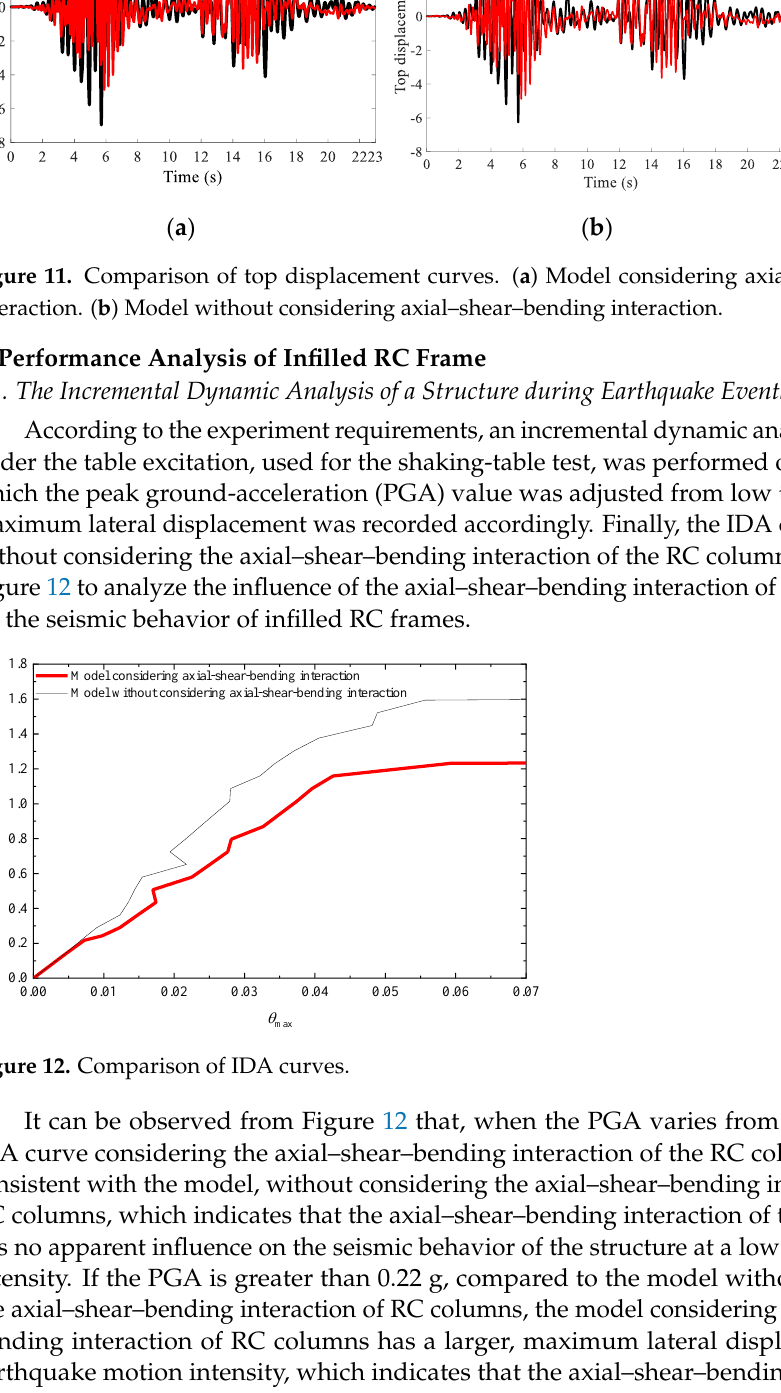
Figure 13. Comparison of pushover curves. It can be observed from Figure 13 that, when the top displacement is less than 50 mm, the pushover curves obtained from the two models are almost equal. When the top displacement is greater than 50 mm, yield occurs when considering the axi- al – shear – bending interaction of RC columns; then, the pushover curve shows a degra- dation stage. Similarly, after the top displacement exceeds 53 mm, yield occurs without considering the axial – shear – bending interaction of RC columns and the pushover curve also shows a continued degradation stage. As the top displacement increases, the curve considering the axial – shear – bending interaction of RC columns degrades more rapidly than the curve without considering the axial – shear – bending interaction of the RC col- umns. When the roof drift ratio reaches 3.5% (top displacement equal to 100 mm) and 5.0% (top displacement equal to 150 mm), the difference in the load capacity between the two models is approximately 20% and 35%, respectively. The results demonstrate that, without considering the axial – shear – bending interaction of the RC columns, the degra- dation characteristics of the structure under higher displacement (e.g., 3.5% roof drift ra- tio) values are overestimated.